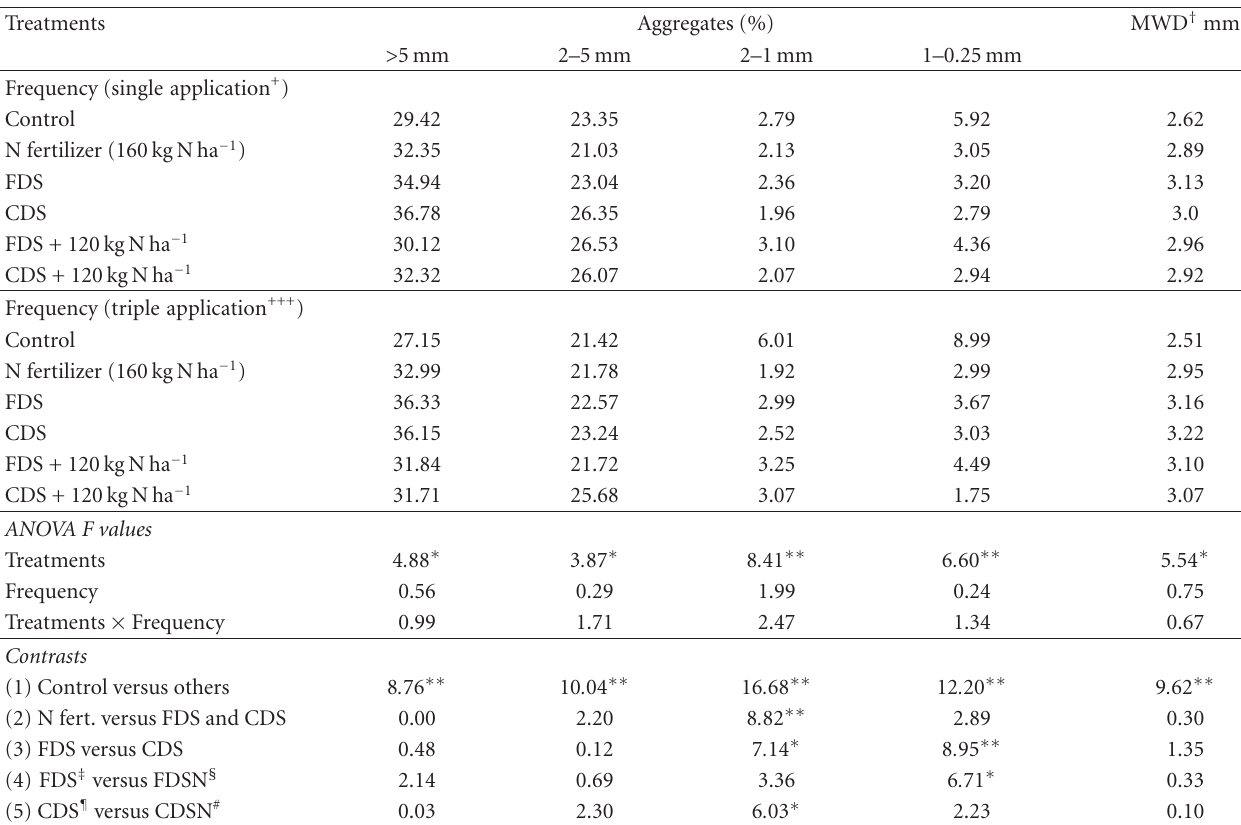
Table 2: Residual e ff ects of applications of fresh and composted paper sludges, and N fertilizer on soil water-stable aggregates in 2004.